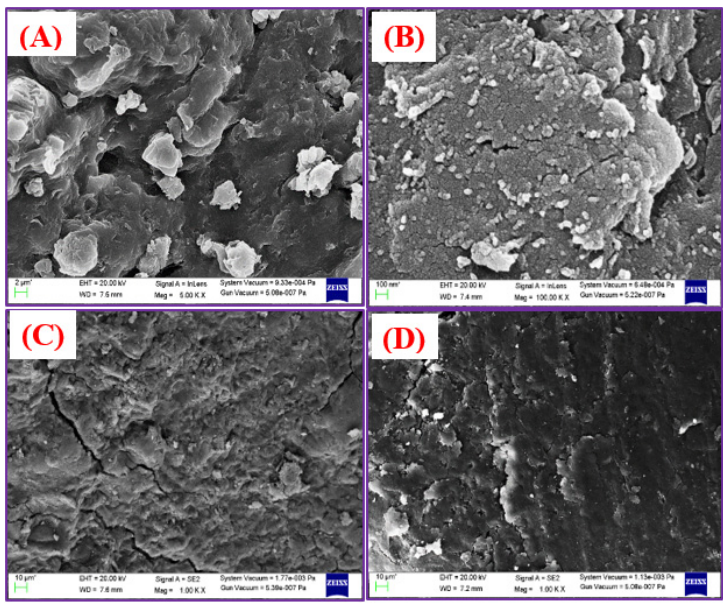
Figure 5. FE-SEM images of ( A ) GO/SA ( B ) Met-GO/SA before adsorption ( C ) after OFX adsorption ( D ) after MOX adsorption on Met-GO/SA surface. ( D ) after MOX adsorption on Met-GO/SA